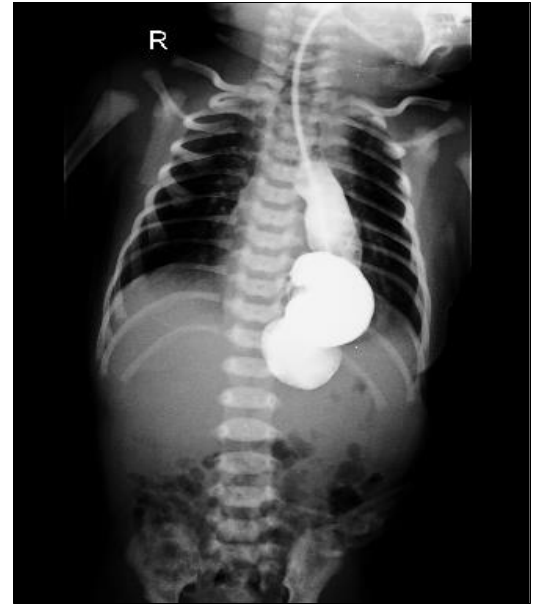
Figure 1: Contrast study showing intrathoracic rotated stomach